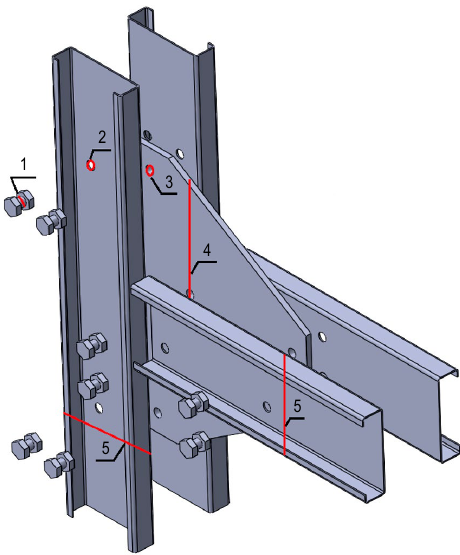
Fig. 6. Exploded view of beam-to-column connection with failure modes marked in red